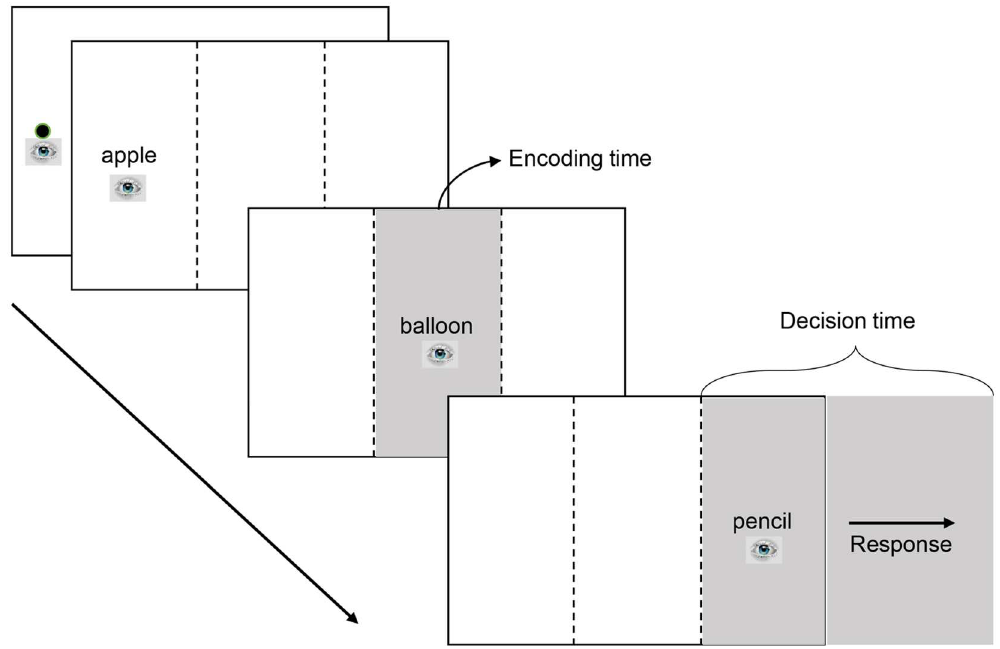
Fig 1. Presentation of stimuli and dependent measuresin Experiment 1. Encodingtime is measured as the gaze duration on the middle word. Decisiontime is the time from the onset of the last word until the indicationof a response by a speeded key-press. A gaze-contingent display techniquewas used in which the words were masked except when the participantlooked at them during the first readingpass from left to right. This eliminated preview and rereadingof the first and middle